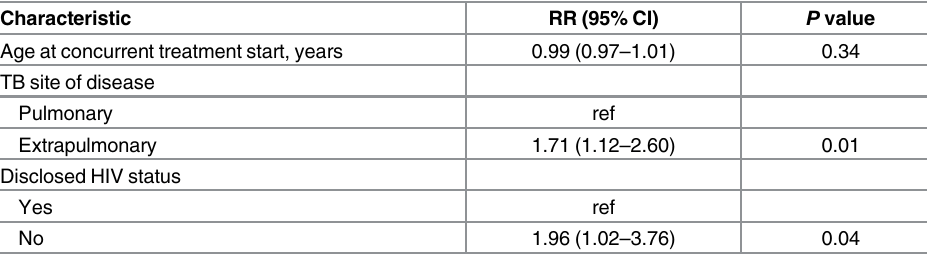
Table 3. Multivariate analysis of the relationship between characteristics of persons receiving con- current TB/HIV treatment in selected THAT ’ SIT clinics and non-adherence to concurrent TB and